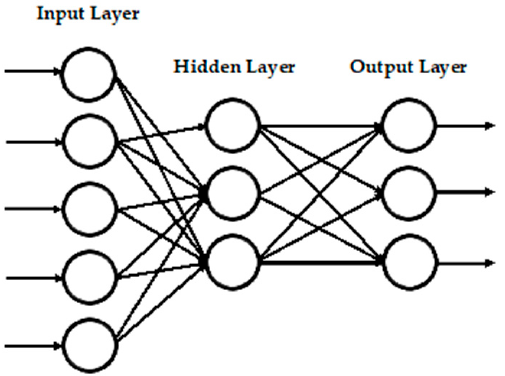
Figure 1. Simple ANN network architecture.